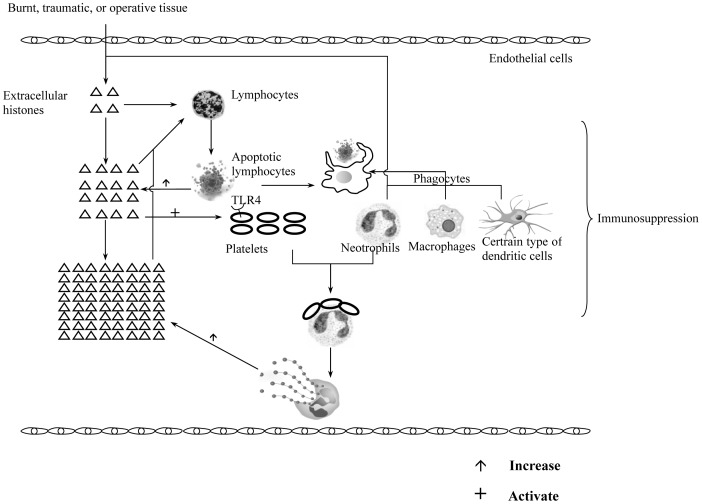
The immunosuppressive condition of sepsis maintains itself by a vicious positive feedback circle caused by extracellular histones.